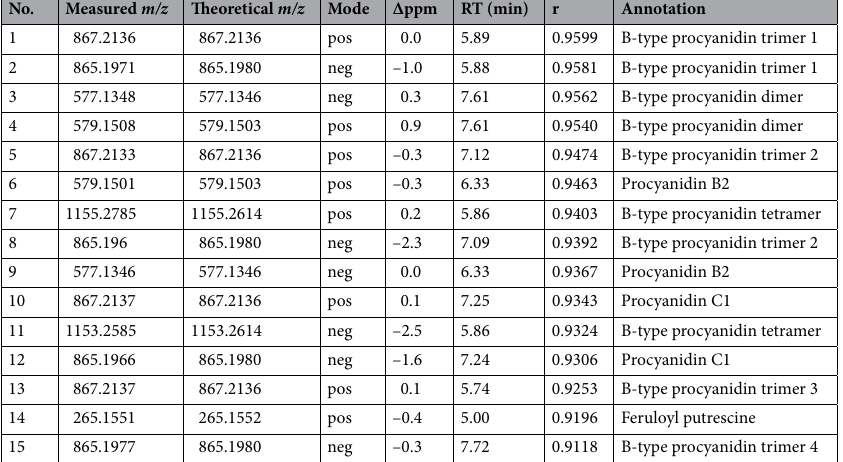
Table 1. Top 15 candidate features from the metabolomic analysis of Viola odorata root fractions based on the Pearson correlation coefficient r. Metabolites were putatively identified (annotated) by analyzing their MS 2 spectra with the exception of procyanidins B2 and C1, which were identified by direct comparison with authentic